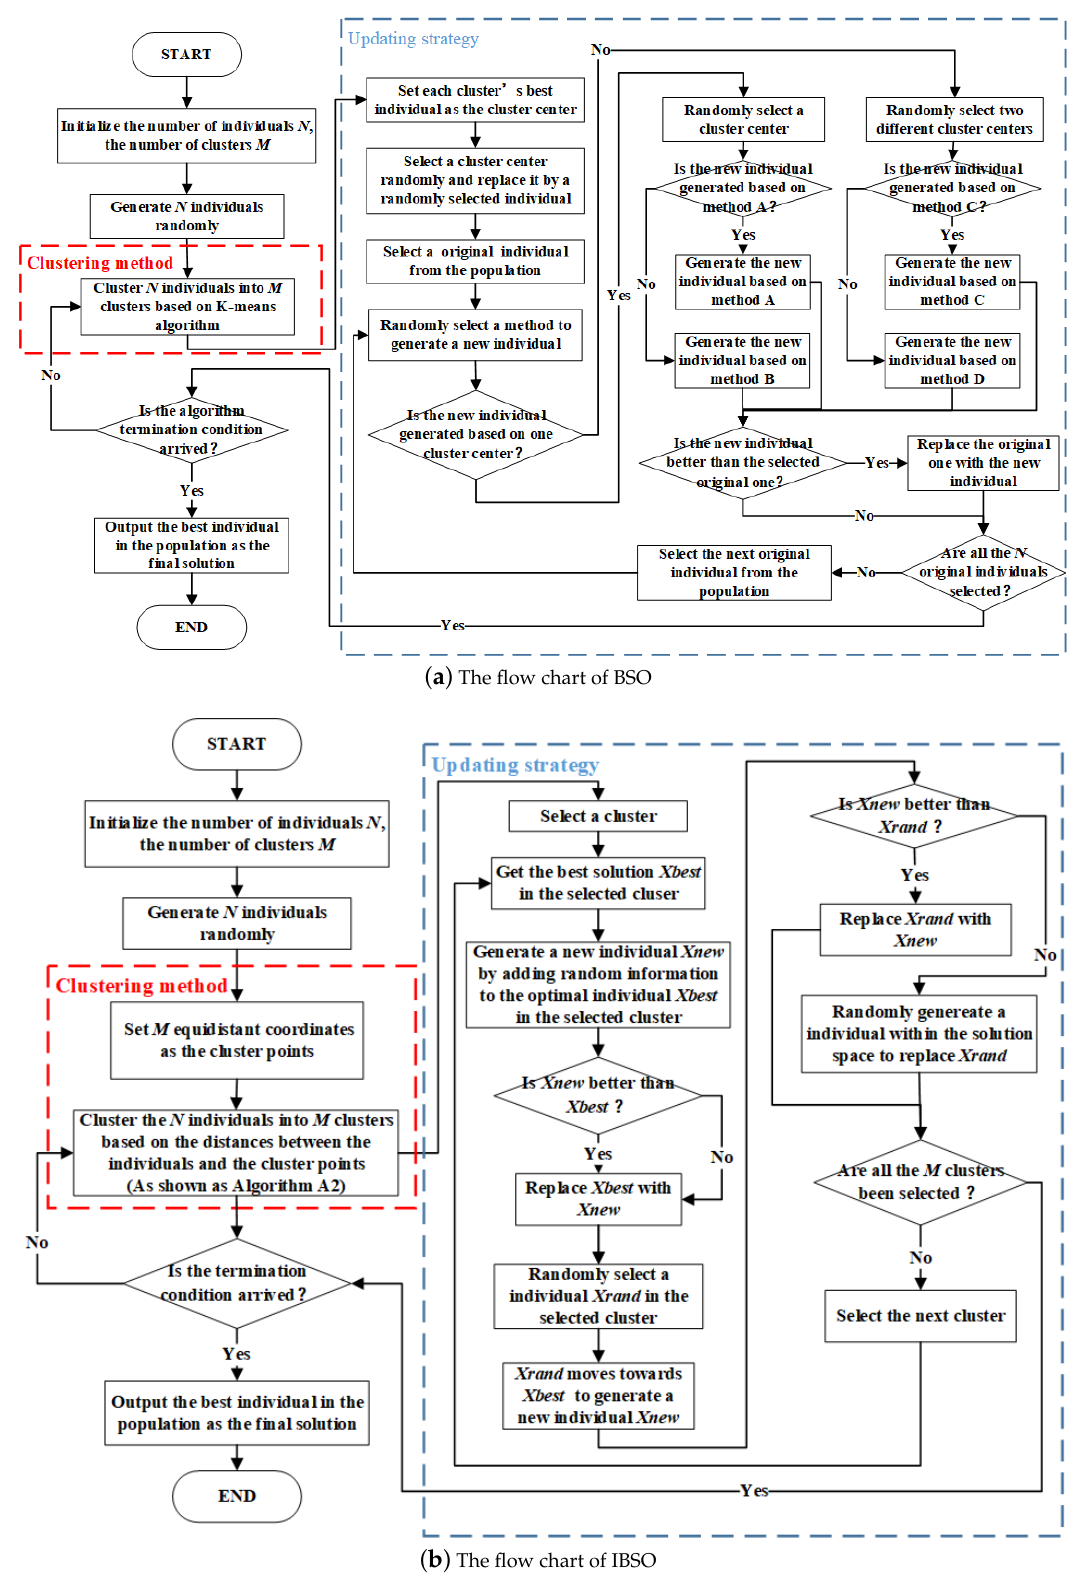
Figure 5. The flow charts of BSO and improved BSO